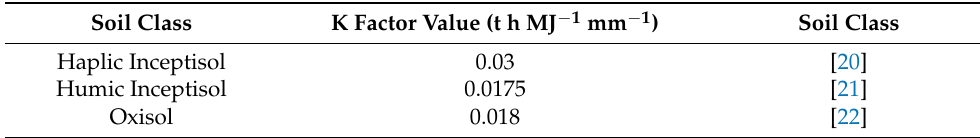
Table 2. K Factor values from literature data base.